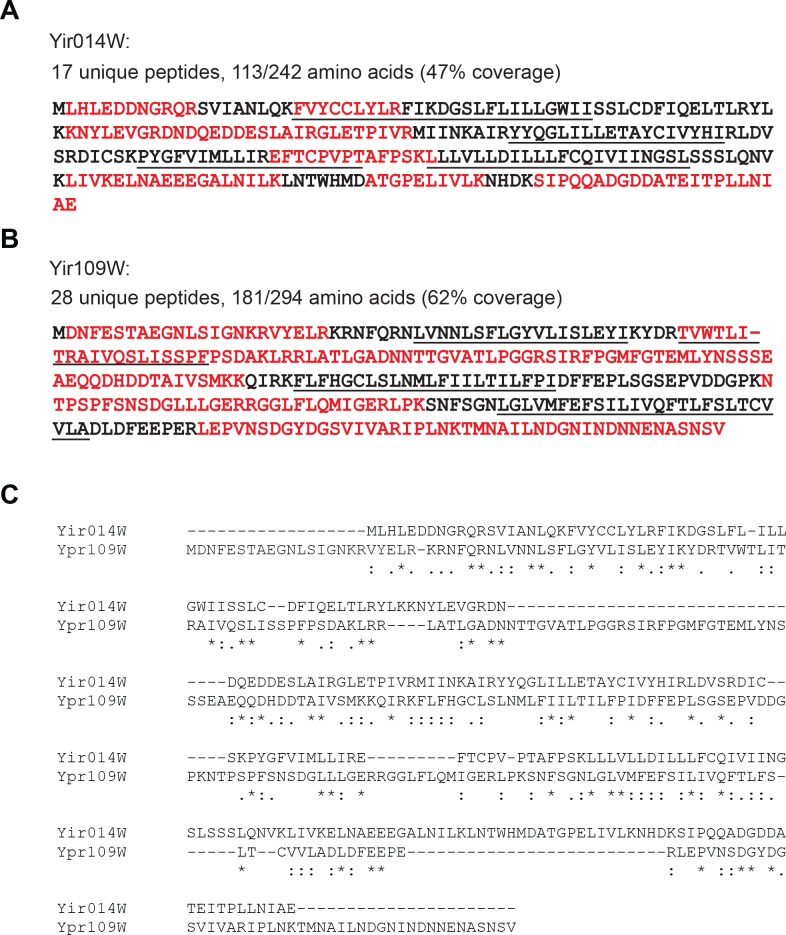
Identification of two new Dsc subunits by mass spectrometry.(A) Mass spectrometry peptide coverage for Yir014W. The peptides identified by mass spectrometry are highlighted in red. The underlined sequences are the predicted transmembrane helices. (B) Mass spectrometry peptide coverage for Ypr109W. The peptides identified by mass spectrometry are highlighted in red. The underlined sequences are the predicted transmembrane helices. (C) Sequence similarity between Yir014W and Ypr109W. The alignment was performed with Clustal Omega (Sievers et al., 2011).